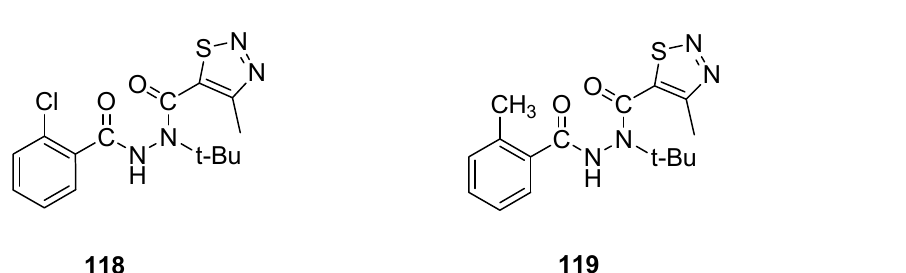
agent, i.e., tebufenozide, was 40%. The scaffold 118 displayed excellent and the highest nozide (40%) and derivative 119 (68%). The EWD group chloro increased the insecticidal activity of scaffold 118 , while ED group methyl decreased the insecticidal potency of Figure 17. Known insecticidal agents 115 – 117 . Figure 17. Known insecticidal agents 115–117 . scaffold 119 [29].